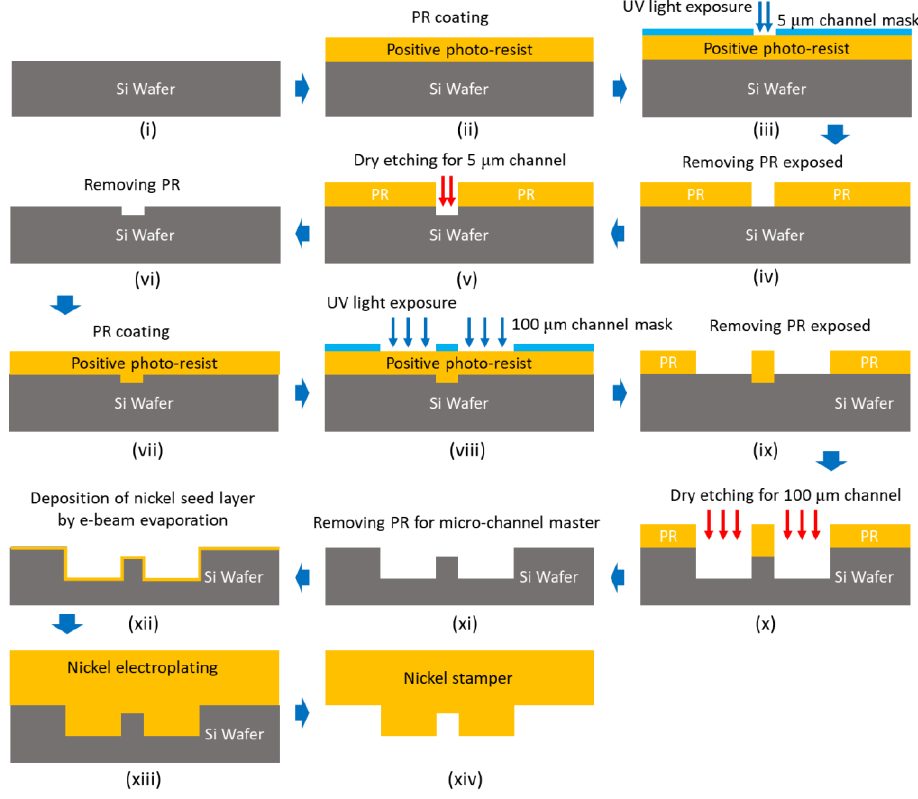
Figure 5. Fabrication procedure for nickel stamper including photo lithography and electroform- ing.